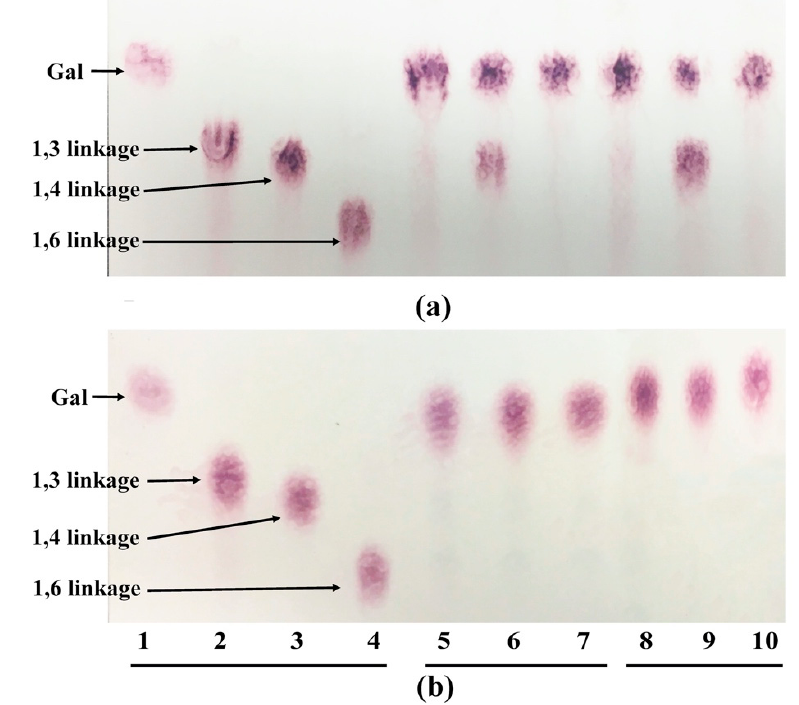
Figure 1. Thin-layer chromatography (TLC) analysis of the degradation products from cytoplasmic and cell wall-associated β -galactosidase extracts from B. longum subsp. longum NCC 2705 ( a ) and Bac. caccae ATCC 43185 ( b ). Lane 1, galactose standard; lane 2 ( β -1,3-galactobiose), 3 ( β -1,4-galactobiose), 4 ( β -1,6-galactobiose), substrate control without crude enzymes; lane 5, 6, 7, crude cytoplasmic enzyme incubated with β -1,3-galactobiose, β -1,4-galactobiose and β -1,6-galactobiose, respectively; lane 8, 9, 10, crude cell wall-associated enzyme incubated with β -1,3-galactobiose, β -1,4-galactobiose and β -1,6-galactobiose, respectively.